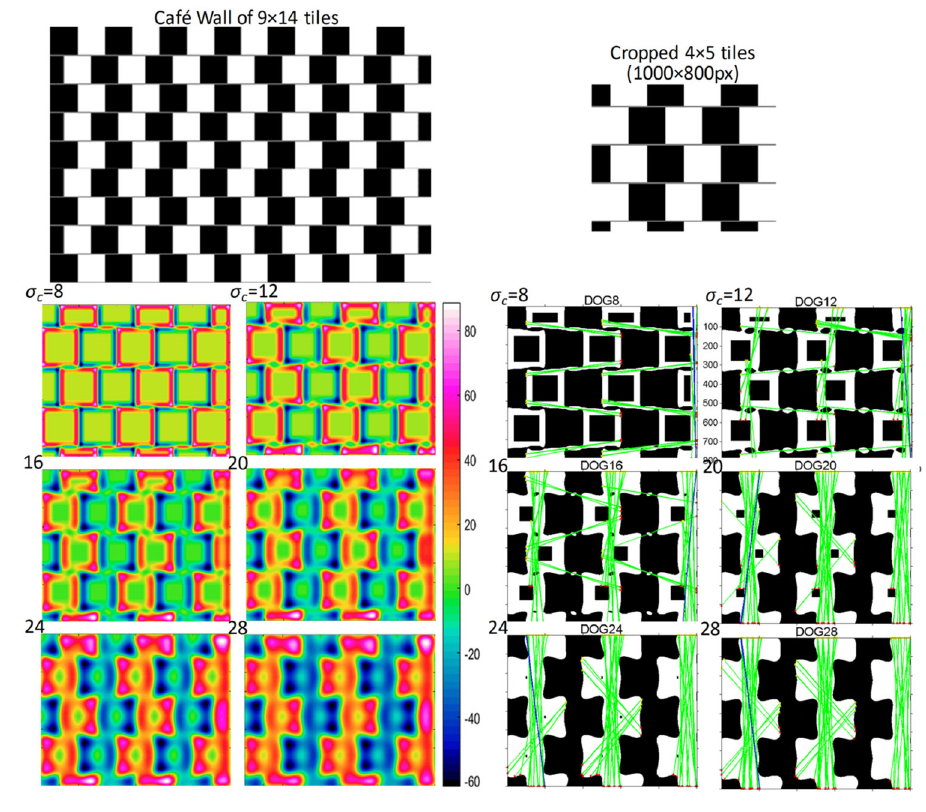
Fig. 5 Top A crop section of 4 9 5 tiles (enlarged) from a Cafe´ Wall of 9 9 14 tiles with 200 9 200 px tiles and 8 px mortar. Bottom left Edge map of the crop section at six scales ( r c ¼ 8 to 28), with incremental steps of 4 in jet white colour map. Bottom right Detected houghlines displayed in green on the binary edge map and around four reference orientations of horizontal , vertical and diagonals . Blue lines indicate the longest detected lines at each scale of the edge map (Reproduced by permission from [145]). (Color